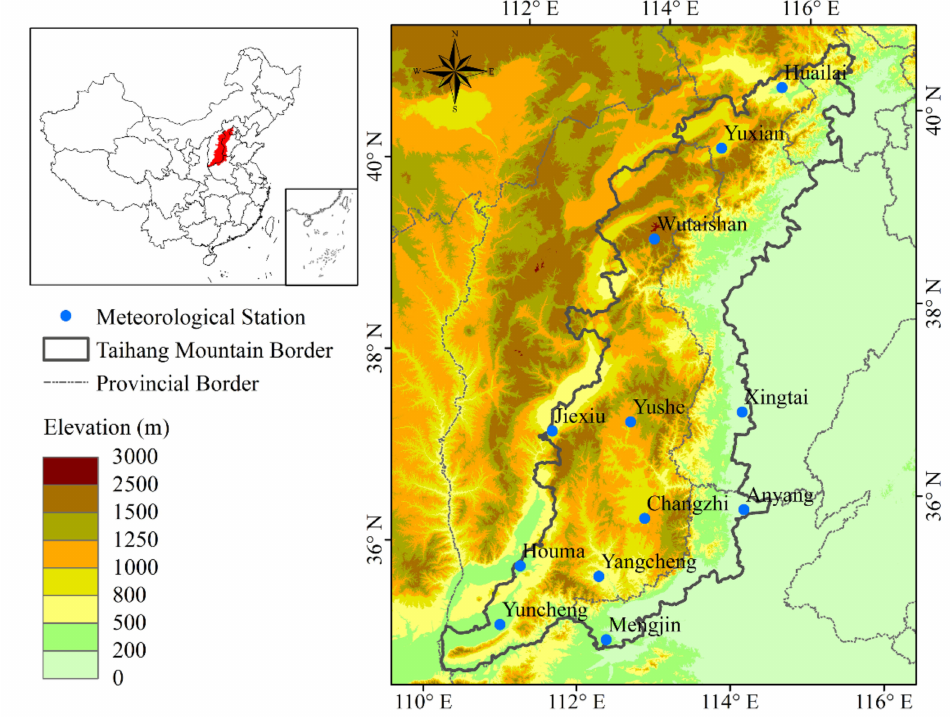
Figure 1. Meteorological stations and elevation patterns in the THM and peripheral